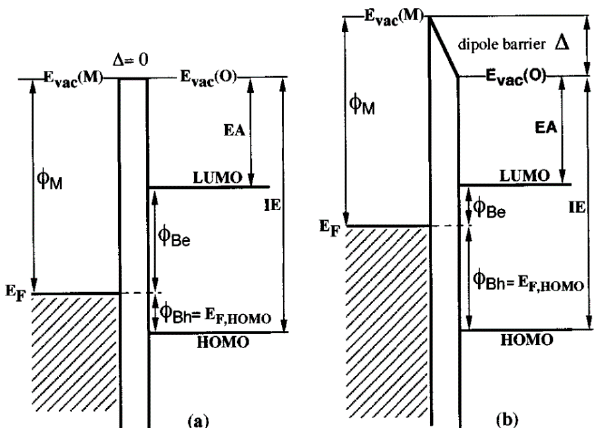
Figure 9. Energy level diagram of a metal–organic semiconductor interface ( a ) without an interface dipole Δ and ( b ) with the interface dipole. ϕ M is the work function of the metal, E F is the Fermi level, EA and IE are the electron affinity and ionization potential of the organic semiconductor, respectively; ϕ Be and ϕ Bh are the electron and hole barriers, respectively; HOMO and LUMO are the highest occupied molecular orbital and lowest unoccupied molecular orbital of the organic semiconductor, respectively; and E vac (O) is the vacuum level in the organic semiconductor, while E vac (M) is the metal vacuum level. Reproduced with permission from Ref. [49]. Copyright 1998 AIP Publishing LLC.